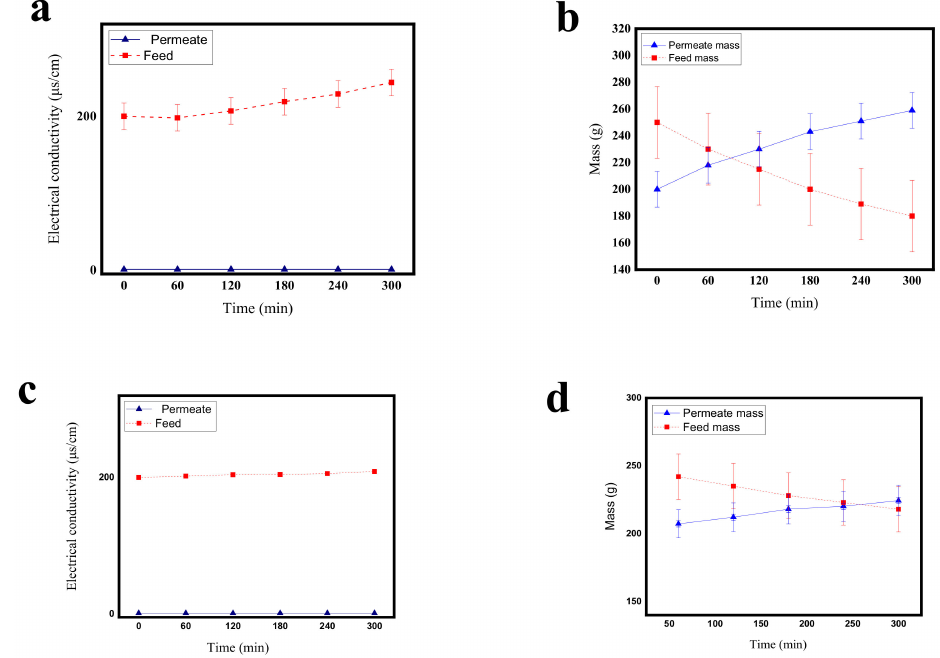
Figure 8. ( a ) The electrical conductivity-time diagram of the membrane distillation process using the PVDF membrane; ( b ) Mass-time diagram of the membrane distillation process using the PVDF membrane; ( c ) Electrical conductivity-time diagram of the membrane distillation process using the FTCS–TiO 2 –PVDF membrane; ( d ) Mass-time diagram of the membrane distillation process using the FTCS–TiO 2 –PVDF